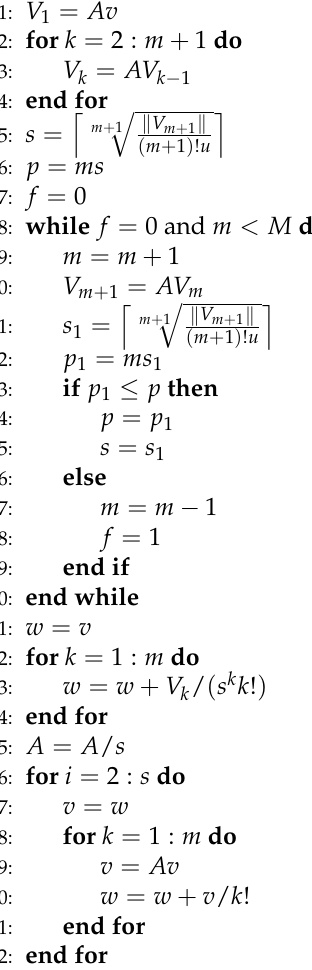
Algorithm 2 Given a matrix A ∈ C n × n , a vector v ∈ C n , and minimum m and maximum M Taylor polynomial orders, m , M ∈ N , this algorithm computes w = e A v ∈ C n by (5).